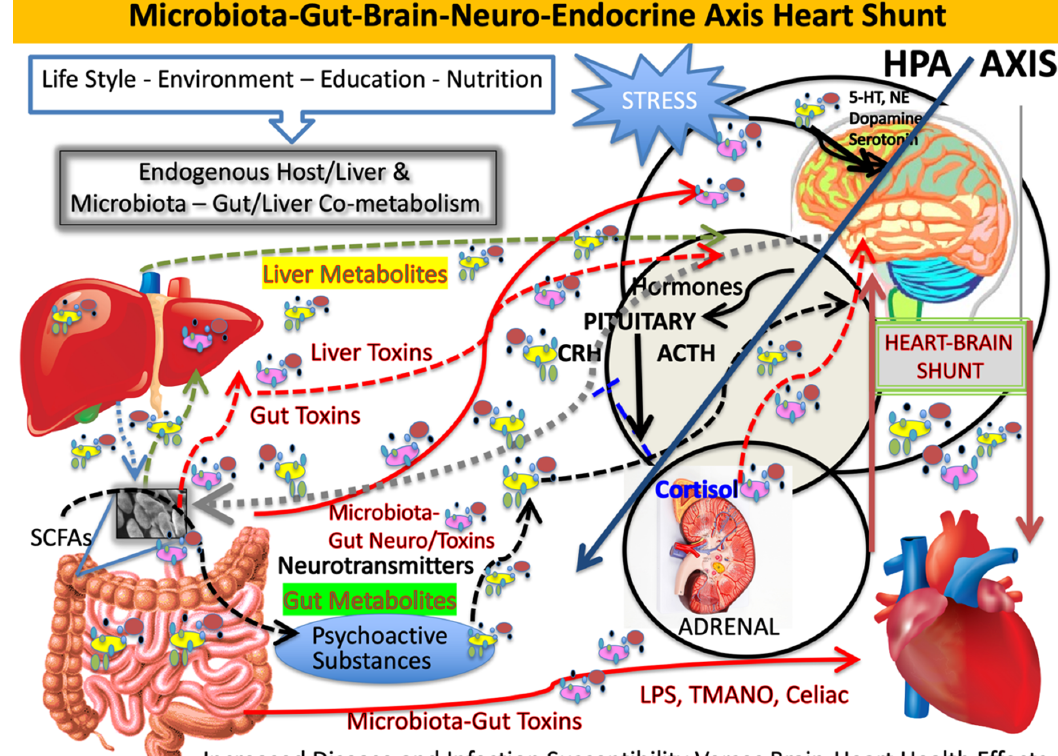
Figure 1. Action of microbiota through hypothalamic–pituitary–adrenal (HPA) axis and brain via chemical messengers. Depicted here is the microbiota-gut-brain axis–heart shunt and the intersection between the gut-derived messengers vs. liver and bacterial toxins or metabolites and the effect that stress and short-chain fatty acids (SCFAs) have on the system. This can arise form prosaic foods, drug action, or co-metabolism between the microbiota and the host.